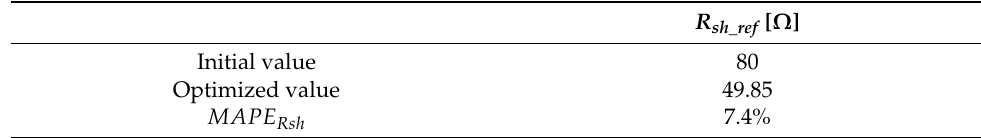
Figure 17. Evolution of 𝑅 (cid:3046)(cid:3035) for constant 𝑇 (cid:3043)(cid:3049) . Figure 17. Evolution of R sh for constant T pv . The coefficient 𝑅 (cid:3046)(cid:3035)_(cid:3045)(cid:3032)(cid:3033) that is the reference value in Equation (5) was extracted, and is displayed in Table 9. The optimized value was 49.85 Ω , and the 𝑀𝐴𝑃𝐸 (cid:3019)(cid:3046)(cid:3035) was 7.4%. Table 9. Extracted reference value R sh_ref .